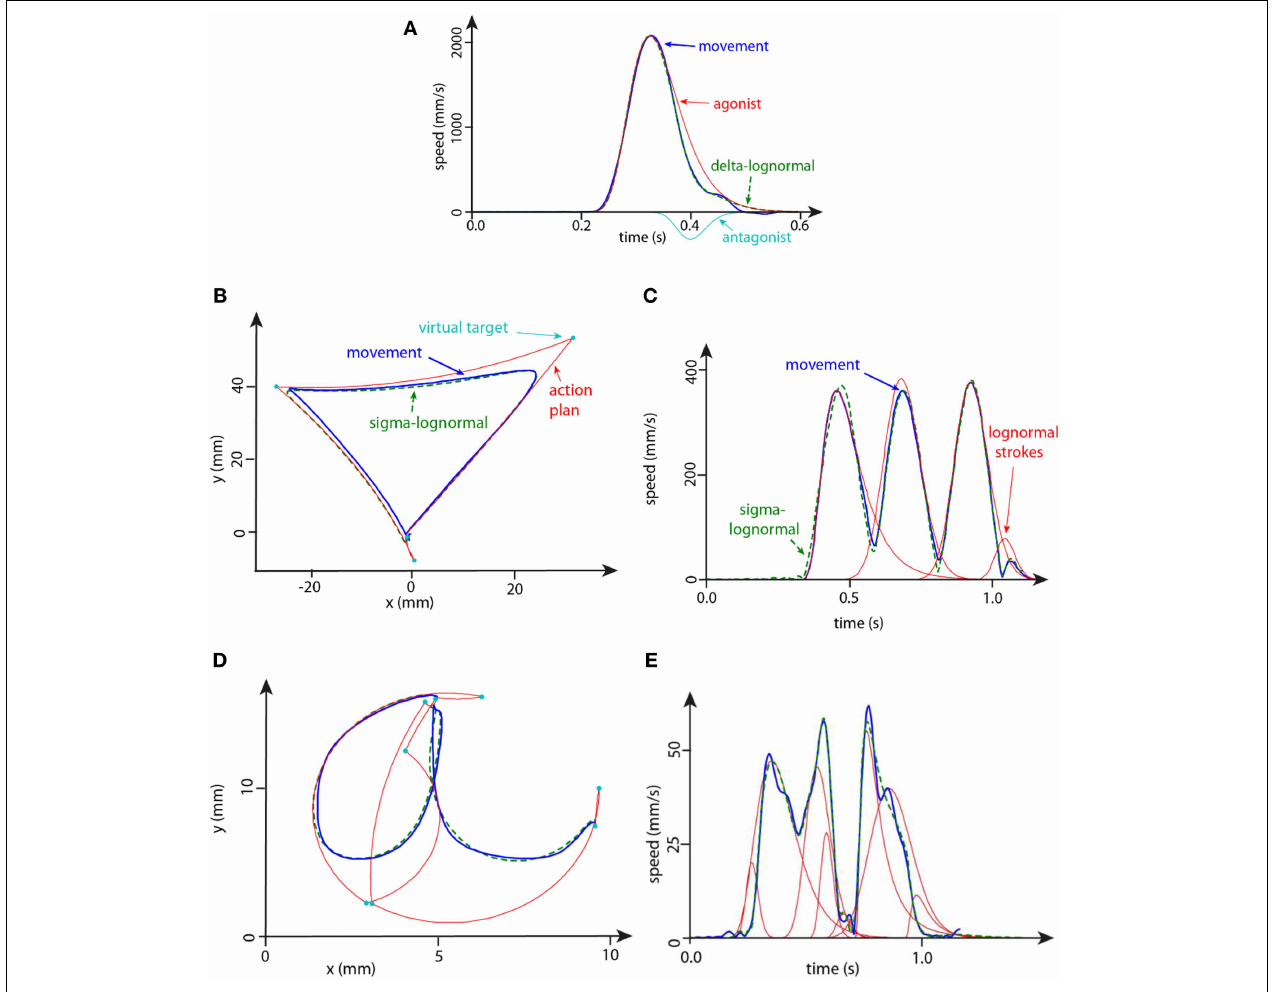
FIGURE 1 | (A) Example of the speed profile of a delta-lognormal modeling for a typical fast reaching movement. (B,C) Example of the trace (B) and the speed profile (C) of the sigma-lognormal modeling of a